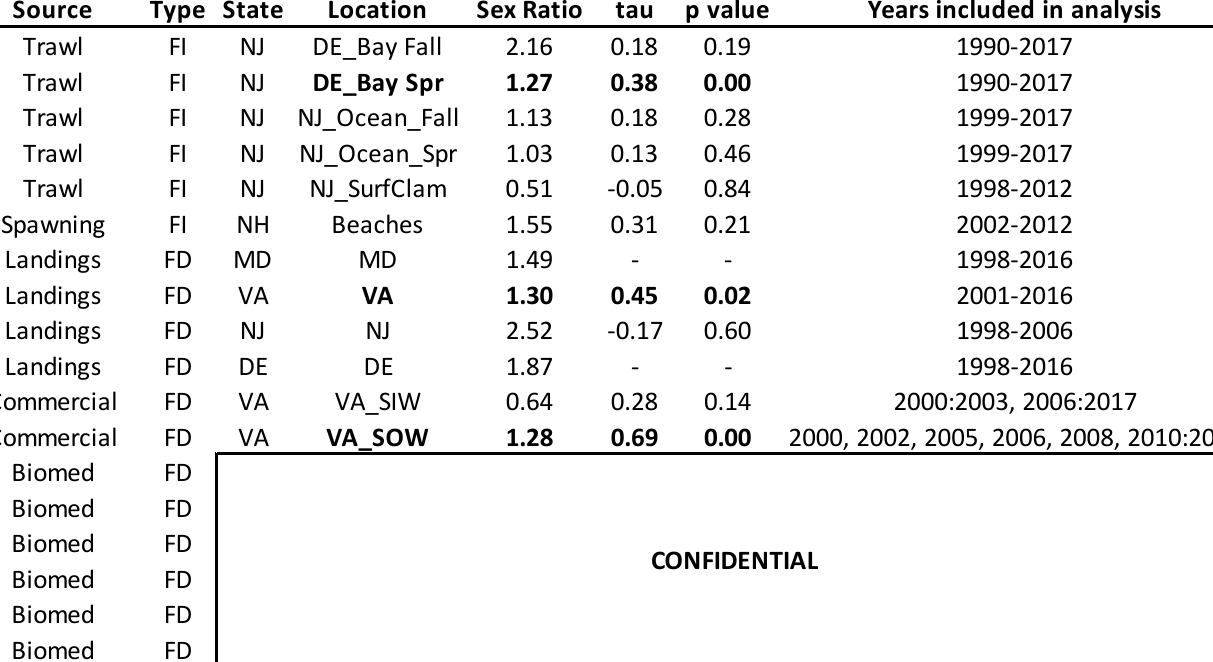
Table 11. Data and results for the Mann-Kendall test of temporal trends in sex ratios, defined as the ratio of males to females. Significant p-values are presented in bold. Trends test not applicable for biomedical data due to the low number of years with sex- specific harvest data. Survey type refers to fisheries independent (FI) and dependent (FD) data. Confidential biomedical data have been removed from this public